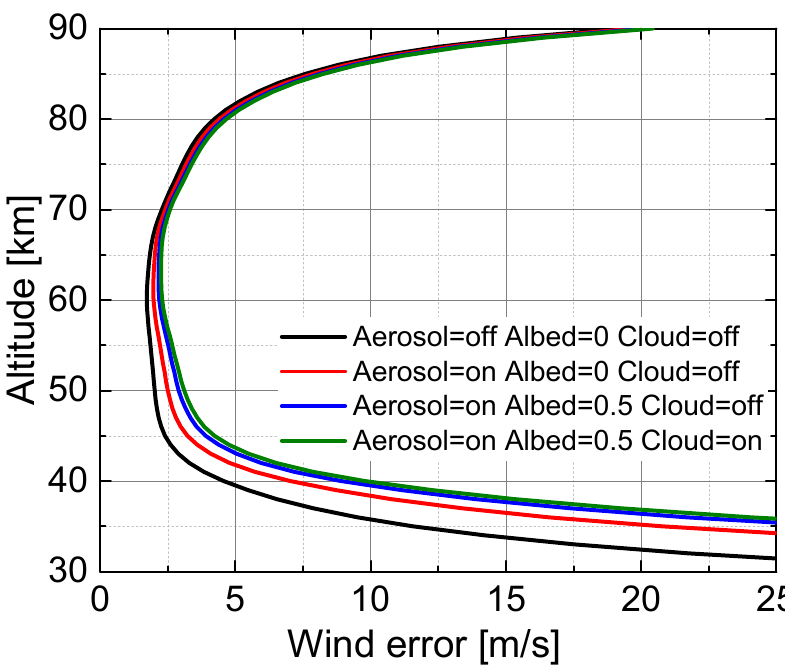
Figure 13. The variations of calculated wind precision profiles with aerosol, albedo, and cloud from 30 to 90 km.